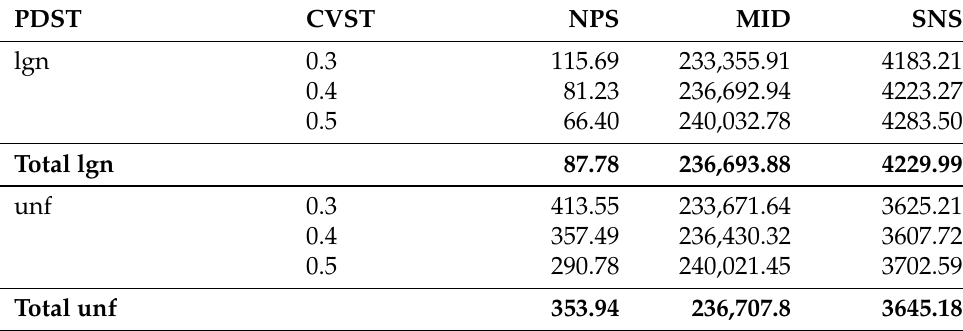
Table 13. Performance multi-objective metrics for the PDST and